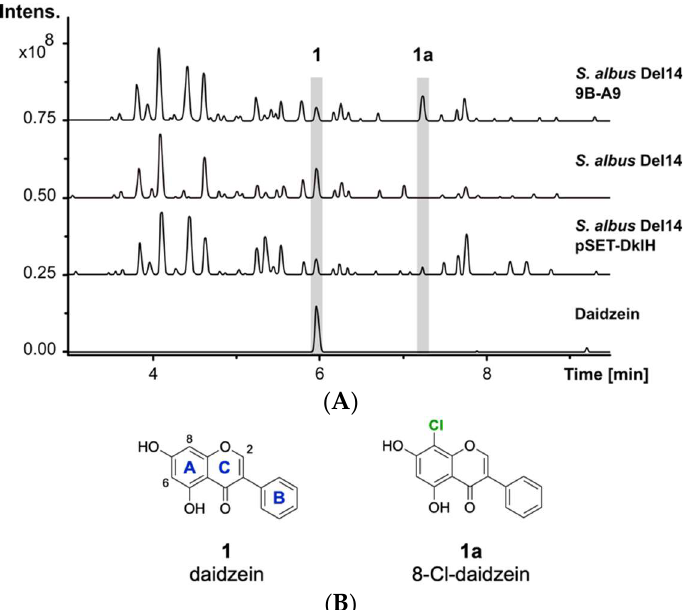
Figure 1. LC-MS detection of 1a . ( A ) Base peak chromatograms of the crude extracts from S. albus 9B-A9, control strain S. albus Del14 and S. albus pSET-DklH and pure compound 1 . The peaks with retention times of 6.0 min and 7.2 min which are marked in grey correspond to 1 and 1a . ( B ) Chemical structures of compounds 1 and 1a (the flavonoid ring nomenclature is highlighted in blue and the chlorine atom is colored in green).